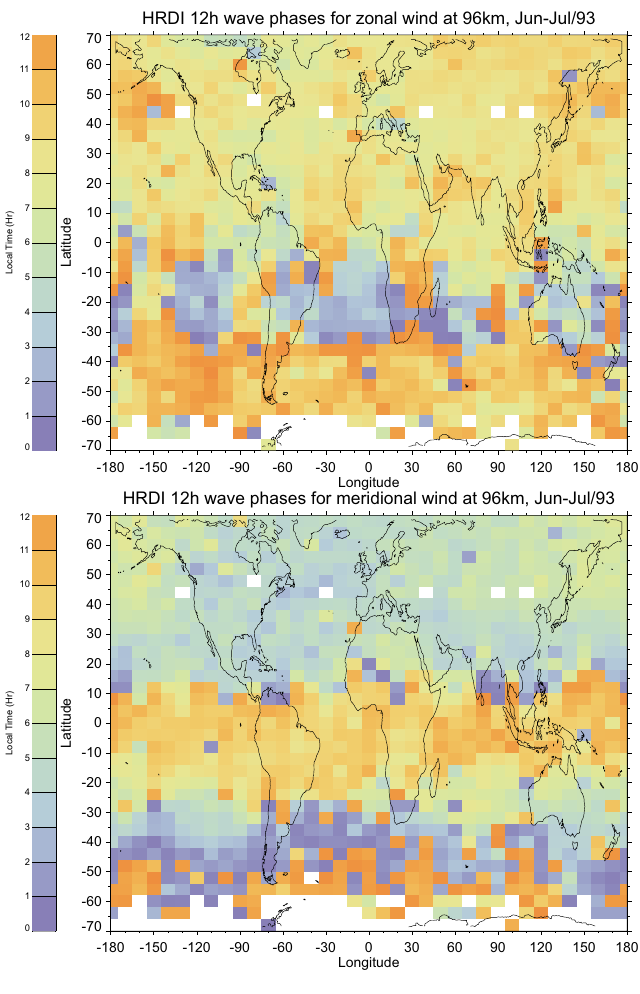
Fig. 8. Contoured plots of 12-h tidal phases for June–July 1993 from